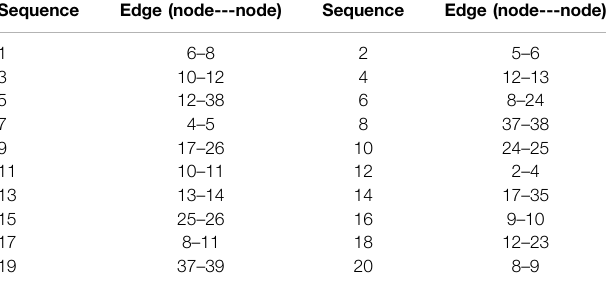
TABLE 7 | The edge ’ s importance sorting table.